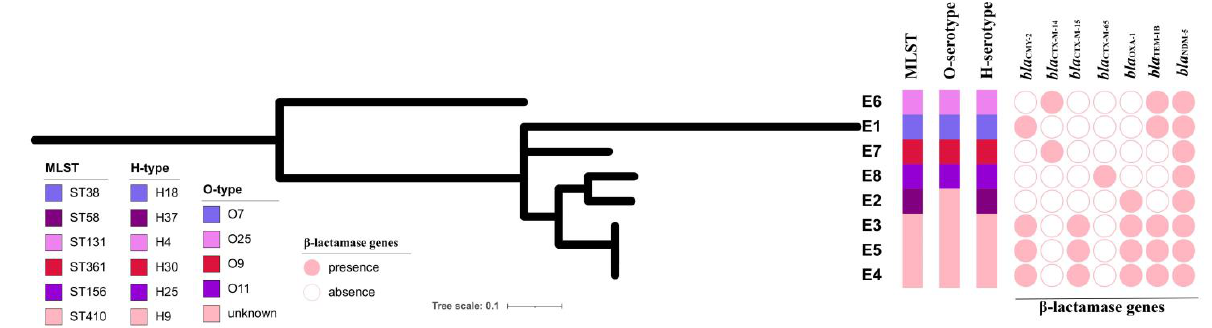
Figure 1. Phylogeny of bla NDM-5 -positive E. coli isolates from bloodstream infections. MLST, O and H serotypes and the presence of β -lactamase genes are plotted.